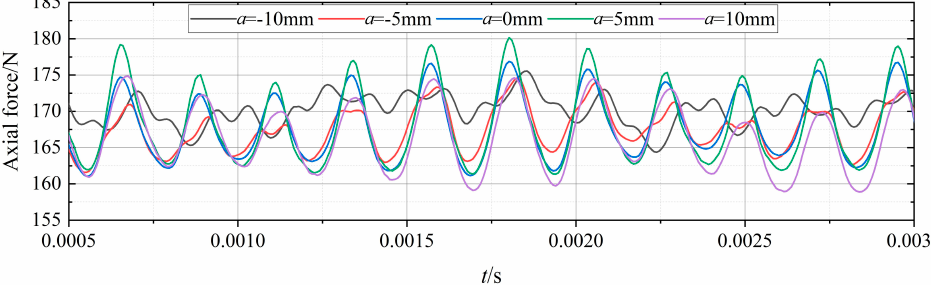
Figure 18. Frequency domain distribution of the aerodynamic exciting force under near-blockage conditions. ( a ) Tangential aerodynamic exciting force; ( b ) Axial aerodynamic exciting force. Table 6 shows the time mean value and the amplitude value at the fi rst-order blade- passing frequency of the aerodynamic exciting force with di ff erent bending coe ffi cients. Compared with the design condition, the mean value of the tangential force increased